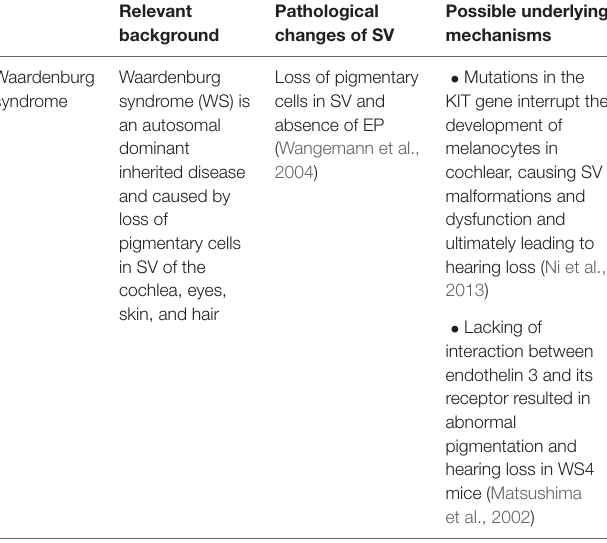
TABLE 1 | Pathological changes and underlying mechanisms of the SV in different